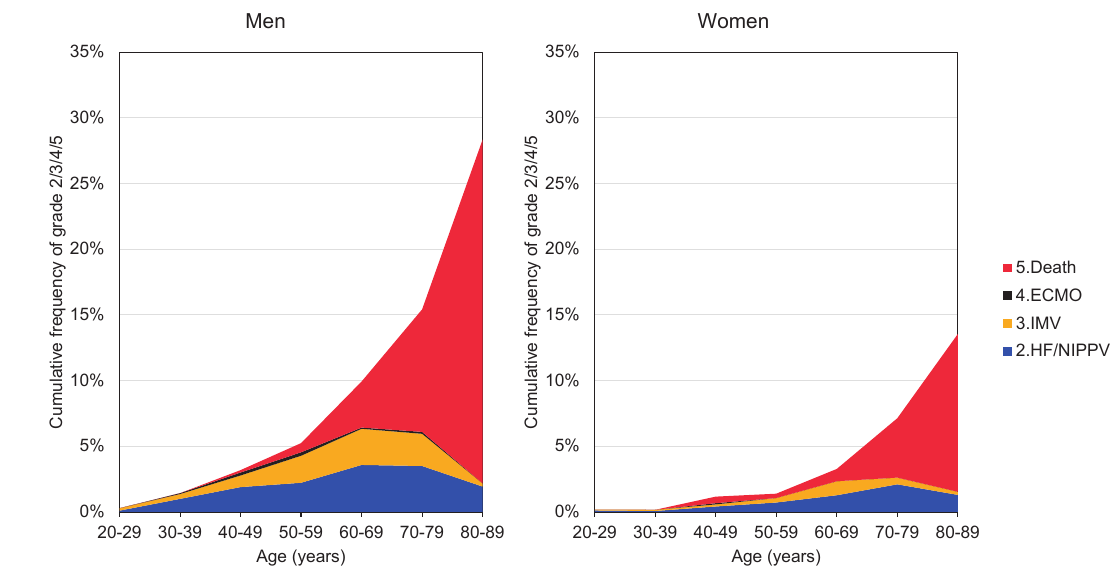
Figure 2. Cumulative frequency of occurrence of each severity grade or death according to sex and age among COVID-19 patients registered in Japan. ECMO, extracorporeal membrane oxygenation; HF, high- fl ow oxygen devices; IMV, invasive mechanical ventilation; NIPPV, non-invasive positive pressure